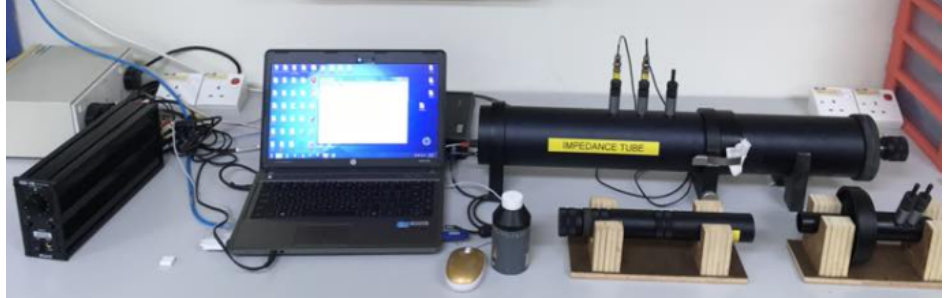
Figure 4. Impedance tube instrument.